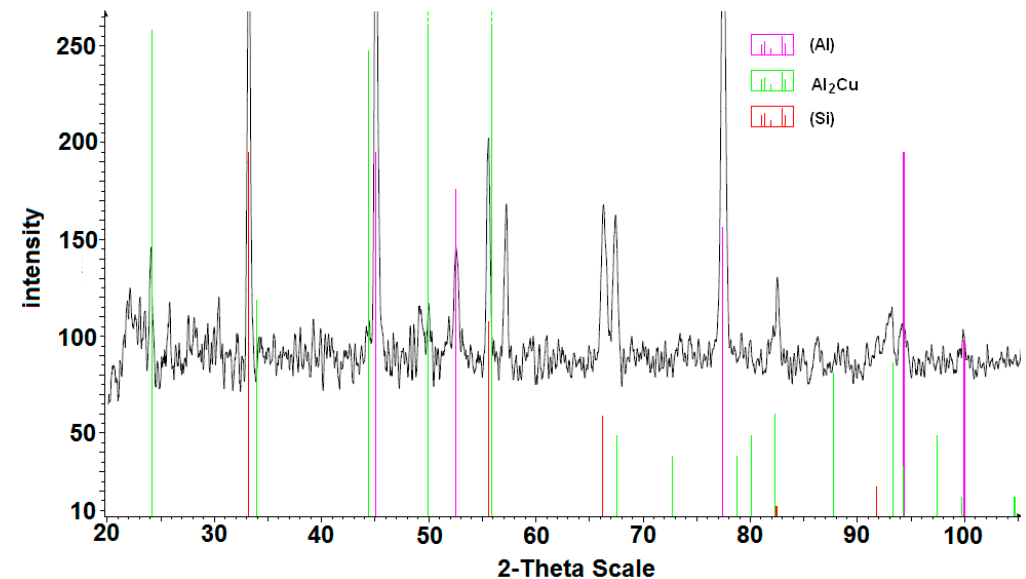
Figure 4. X-ray diffraction pattern for phase identification in the base alloy from the shell mold, identified phases: α (Al), Al 2 Cu, β (Si).